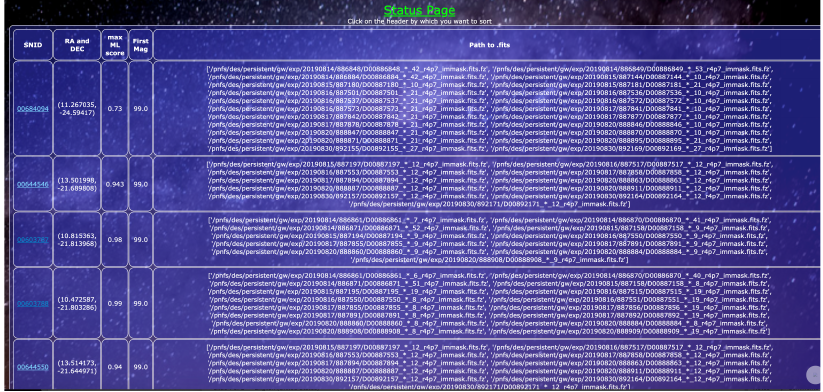
Figure 5. Example web page listing EM counterpart candidates for a given gravitational wave event. One can sort the page based on position and maximum machine learning score. By clicking on a candidate ID, one can view a more detailed candidate-specific page (see Fig.